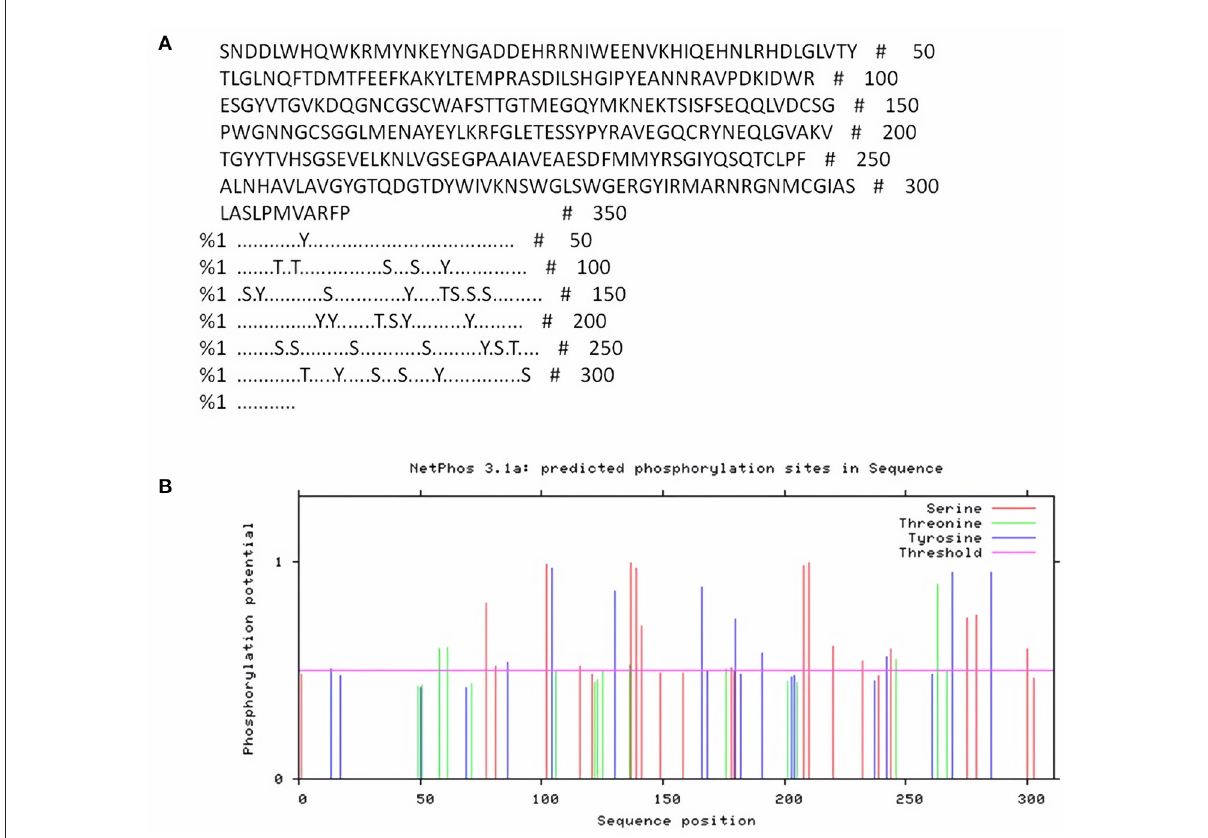
FIGURE1 NetPhos server output for FhCatL1 phosphorylation sites. (A) The number of predicted sites, based on S (serine), T (threonine) and Y (tyrosine); (B) Prediction diagram of FhCatL1 phosphorylation sites (https://services.healthtech.dtu.dk/service.php?NetPhos-3.1).